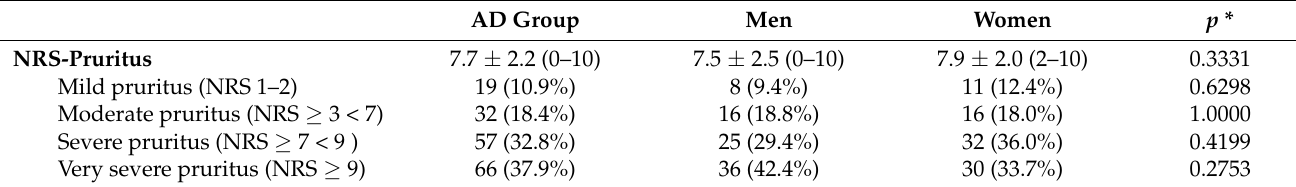
Table 4. Pruritus Numerical Rating Scale (NRS) score—continuous and categorical data of AD.